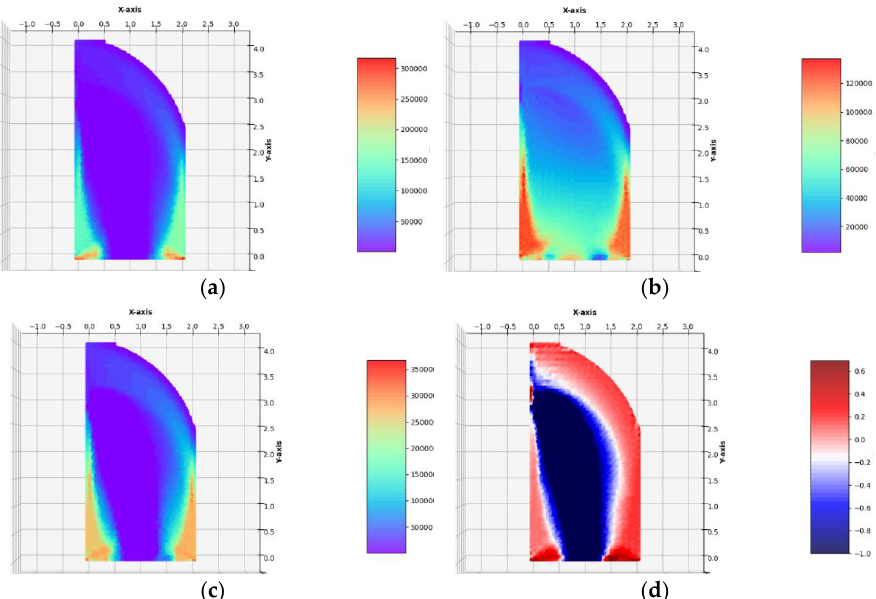
Figure 9. Optimal solutions for the Example 1b. In ( a – d ), the optimal layouts of the bulk, shear and Young moduli k * / b , µ * / b , E * / b and of Poisson’s ratio ν * , with the upper right corner of Ω being cut off, in the case of FEM mesh composed of triangular elements.